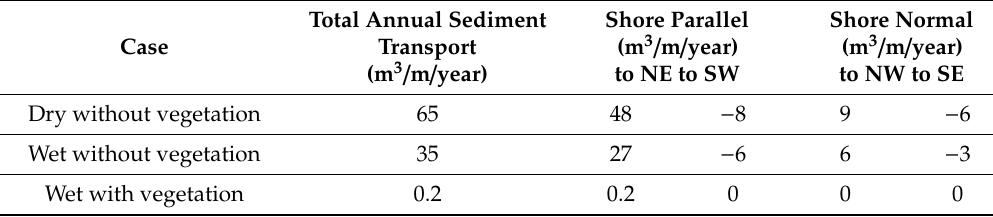
Figure 14. Aeolian sand transport at beach; excluding precipitation ( a ) and including precipitation ( b ); beach position is indicated by the straight line from south-west to north–east. Table 7. Annual aeolian sediment transport components; beach sediment 0.25 mm.